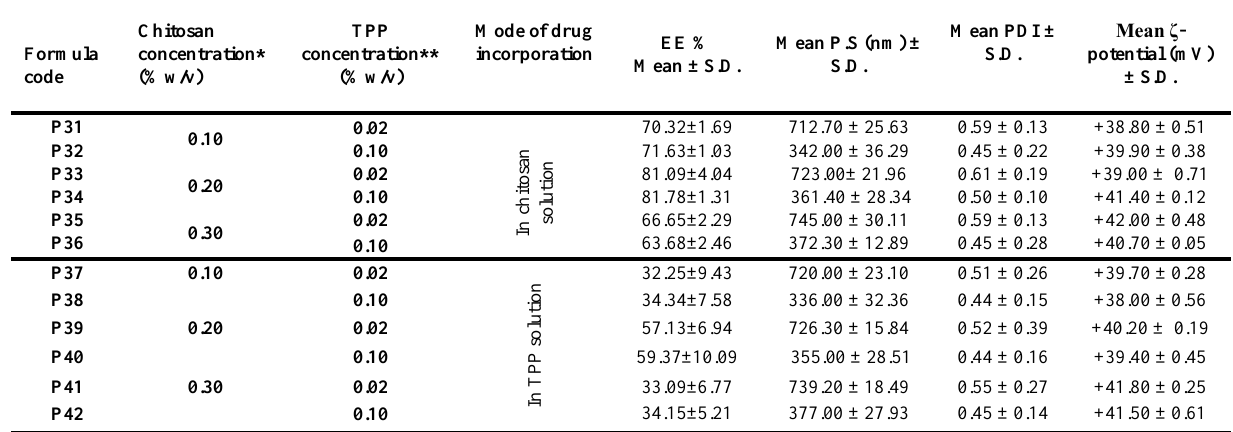
Table 2. Effect of chitosan and TPP concentrations after pH adjustment on the P.S, PDI, ζ-potential, and EE% of loaded CSNPs (the drug was loaded either into the chitosan or TPP solution) (n=3)